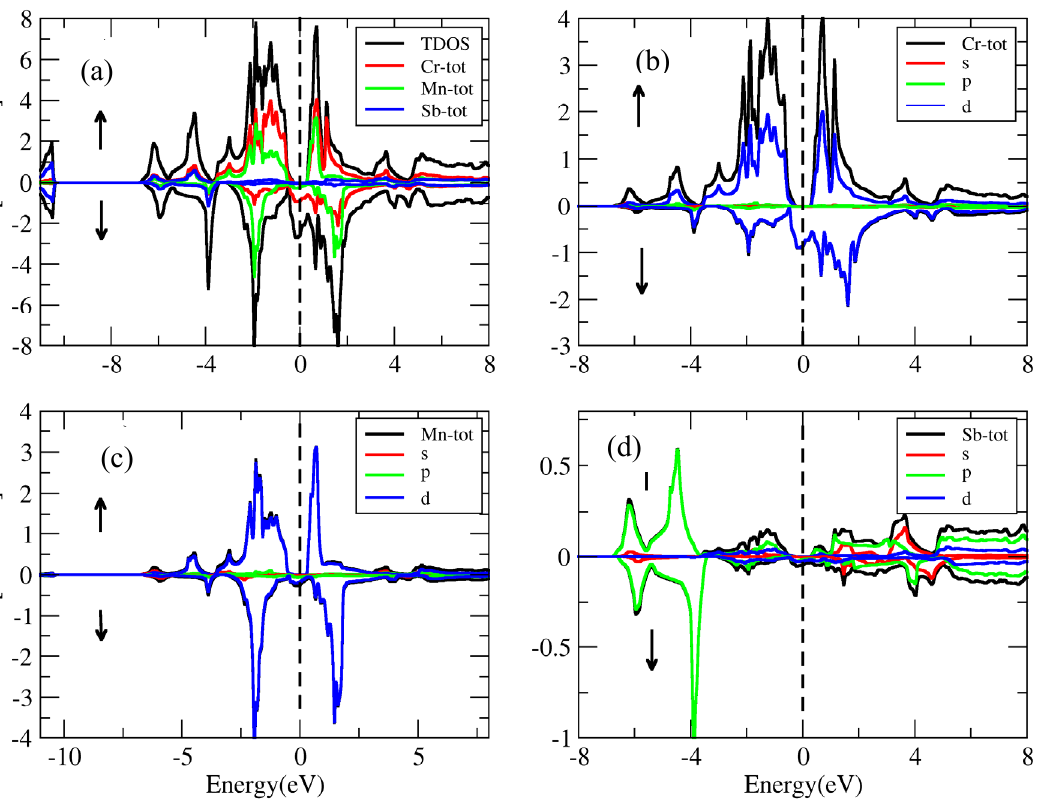
Figure 17. ( a ) Total density of states for the conventional Cr 2 MnSb compound and the partial density of states for ( b ) Cr atom, ( c ) Mn atom and ( d ) Sb atom.